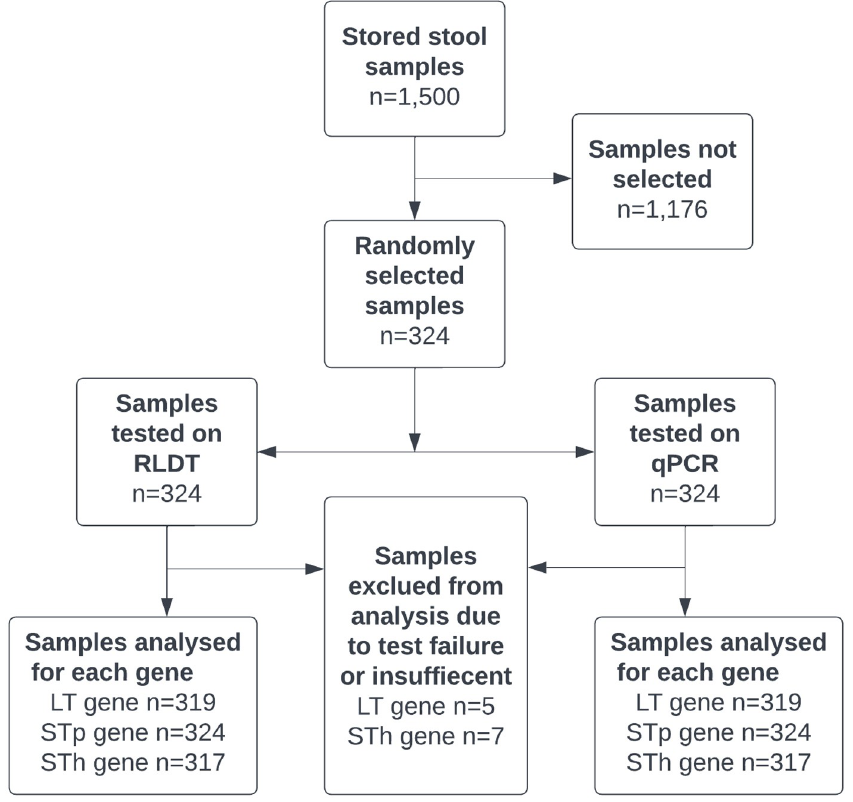
Fig 1. Study participant flow chart. Note: Samples were excluded from analysis due to either qPCR test failure or the sample was insufficient for repeat DNA extraction.